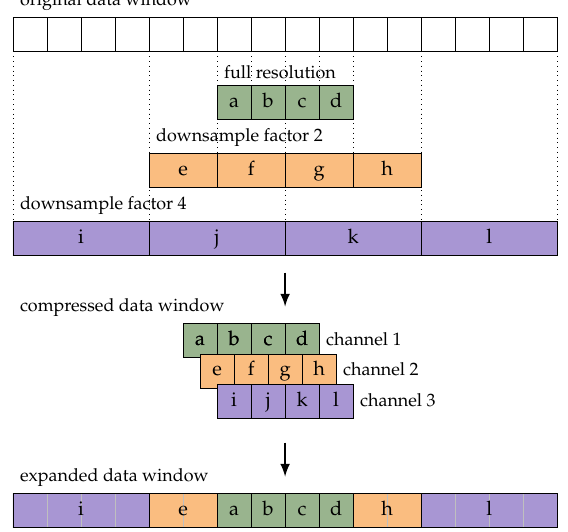
Figure 2. Schematic illustration of multi-resolution compression and expansion of data